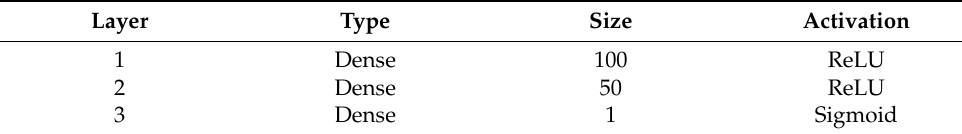
Table 2. Structure of ANN